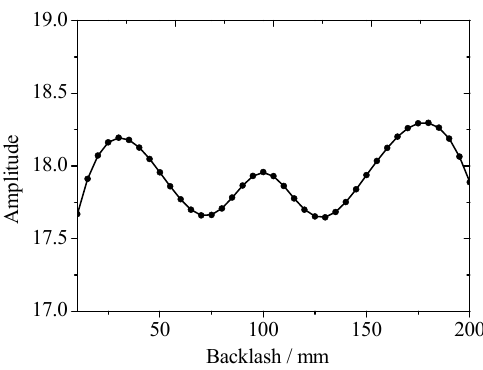
Figure 13. The amplitude of torsional vibration of planet carrier under different backlash.